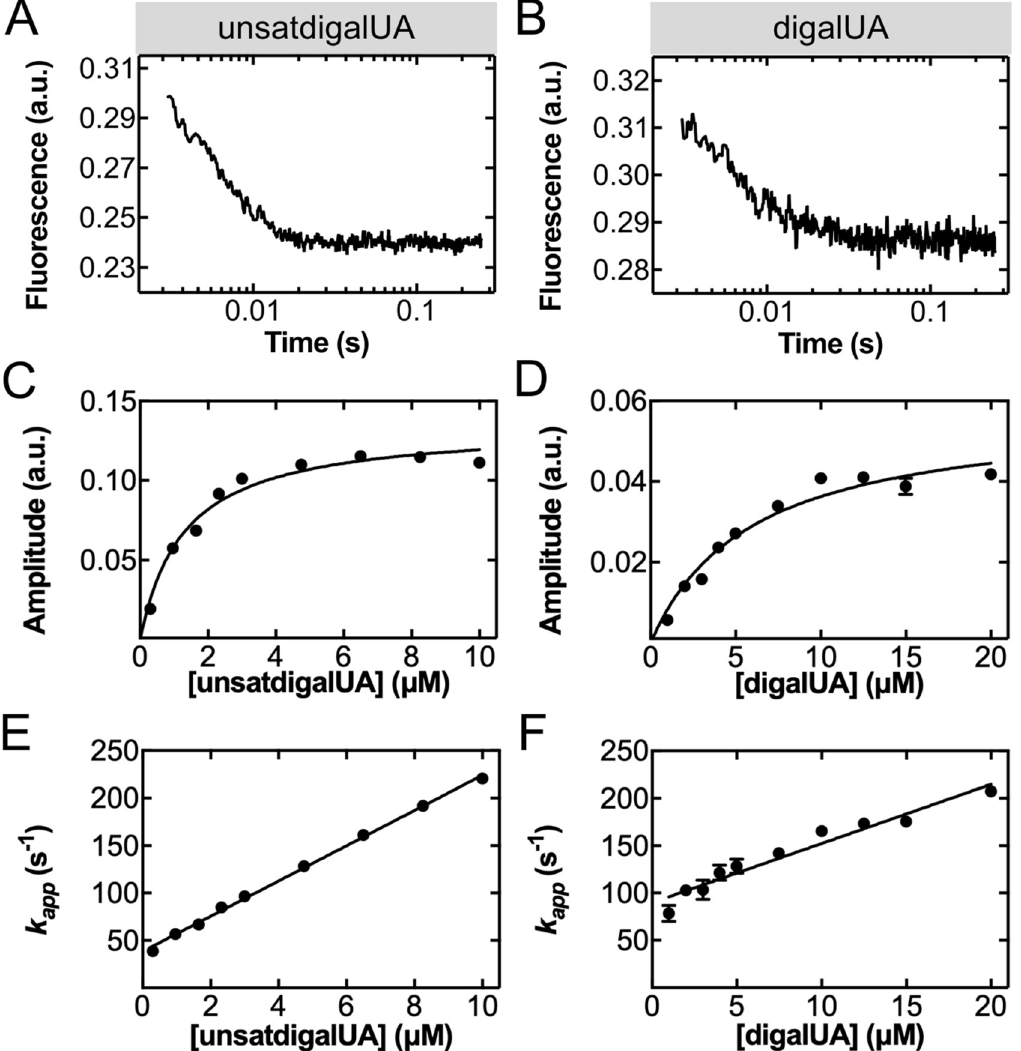
Figure 3. Concentration dependence of unsatdigalUA association rate and digalUA association rate. Representative fluorescence time course of 100 nM TogB D363C-MDCC binding 10 μ M unsatdiga-